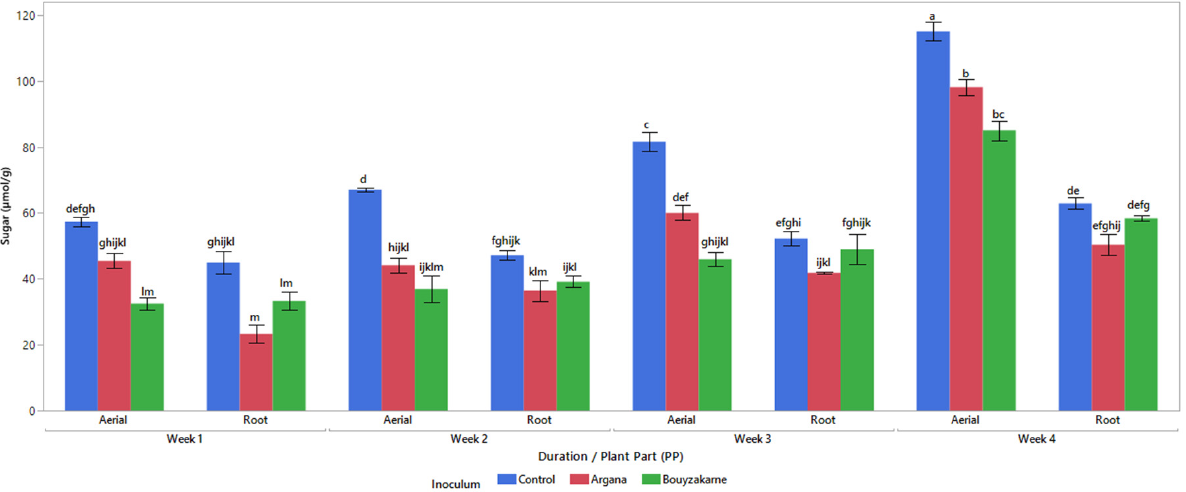
Figure 7. Soluble sugar content of the leaves and roots of mycorrhizal and non-mycorrhizal Argan plants subjected to the stress of soil water deficit for one month (each error bar is constructed using 1 standard error from the mean). Values with different letters are significantly different (Tukey’s test p ≤ 0.05).